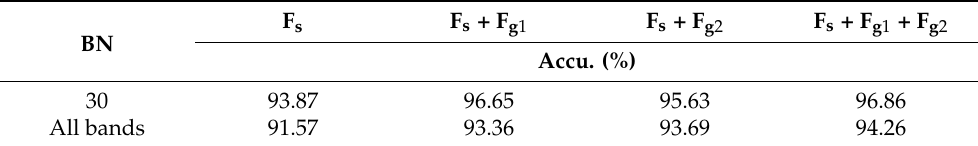
Table 9. Combination classification results (%) of spectral features and spatial features of the Baffin Bay